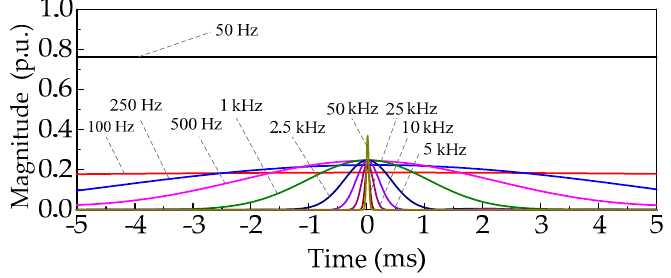
Figure 1. The magnitude of the frequency components of a signal extracted by the S transform.